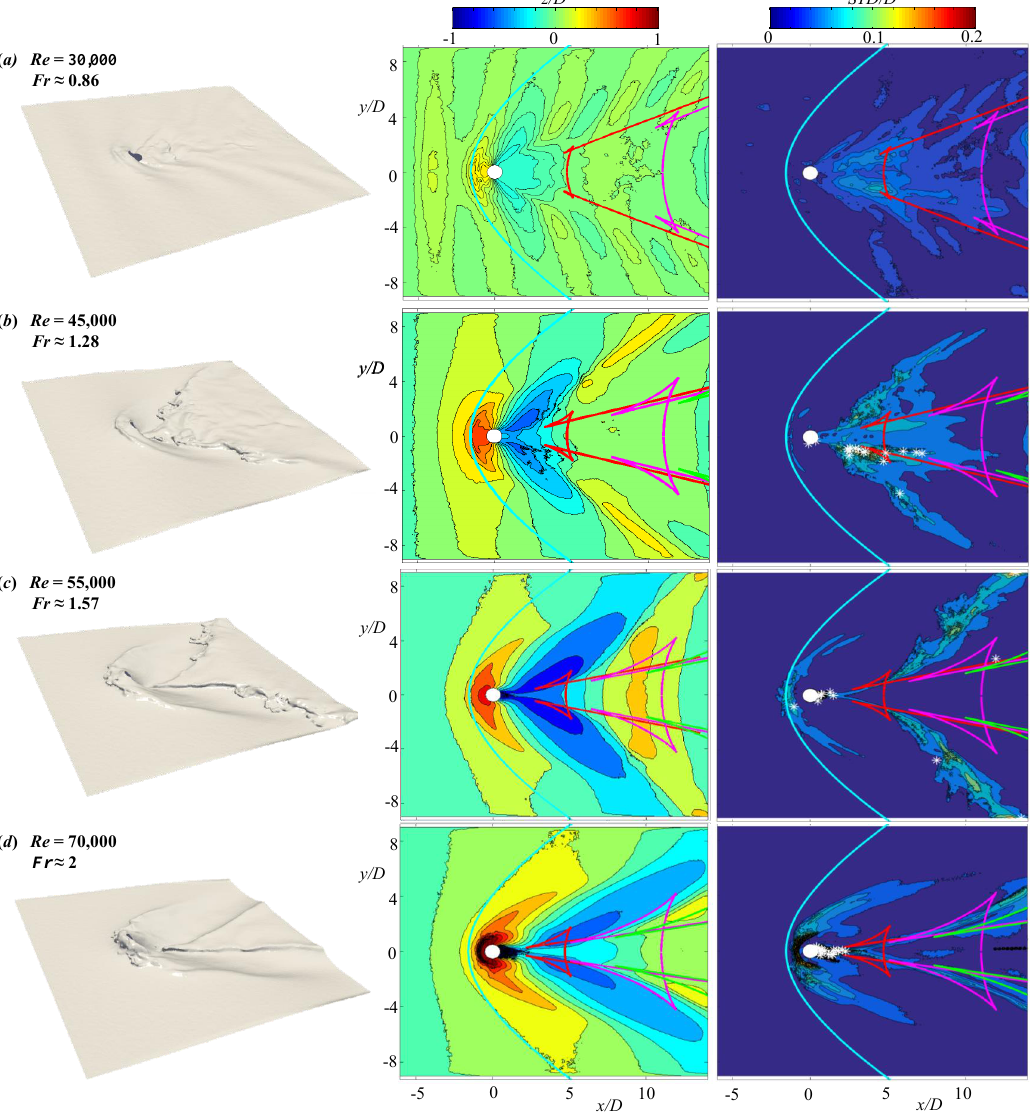
Figure 5. From left to right, the instantaneous isosurface of ψ = 0.5, the time average of the elevation height and the associated relative standard deviation ( STD/D ). The coloured lines represent crest lines, as discussed in the text. ( a ) Re = 30,000, Fr = 0.86; ( b ) Re = 45,000, Fr = 1.28; ( c ) Re = 55,000, Fr = 1.57; and ( d ) Re = 70,000, Fr = 2. White stars on the right column correspond to air bubble locations computed at Ut / D =